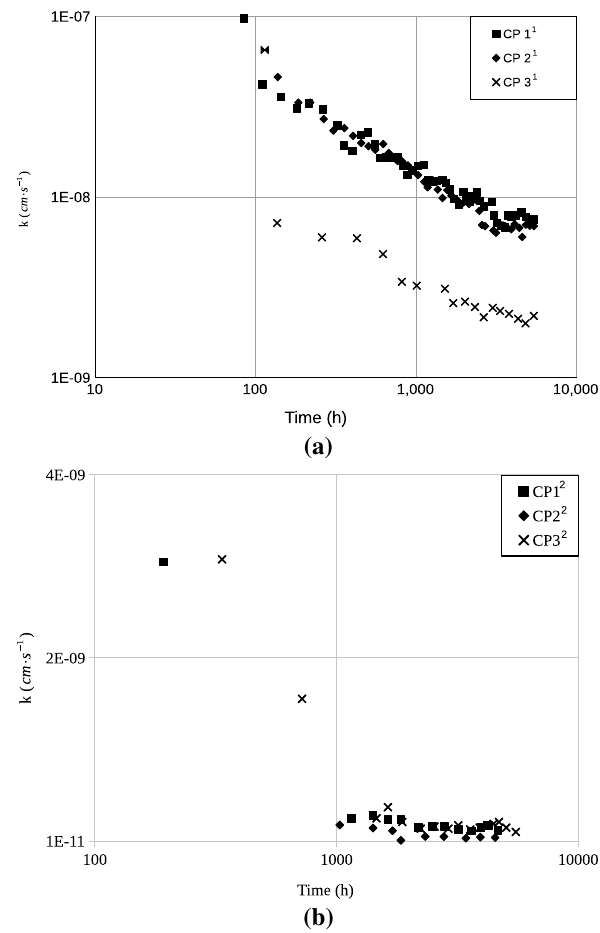
Figure 2. Permeability of soil samples. ( a ) First sampling campaign and ( b ) second sampling campaign.